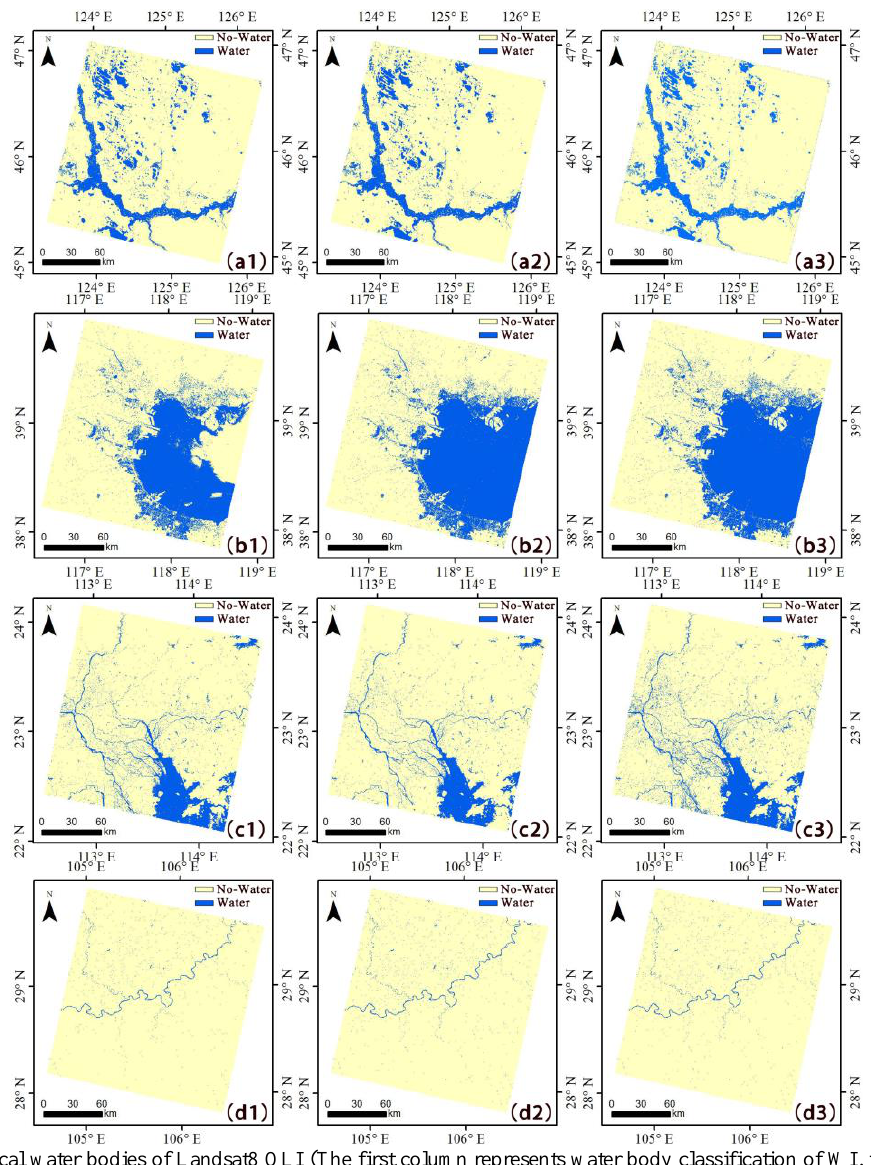
Figure 2. The typical water bodies of Landsat8 OLI (The first column represents water body classification of WI, the second column represents water body classification of ML, the third column represents water body classification of multi-layer perceptron)